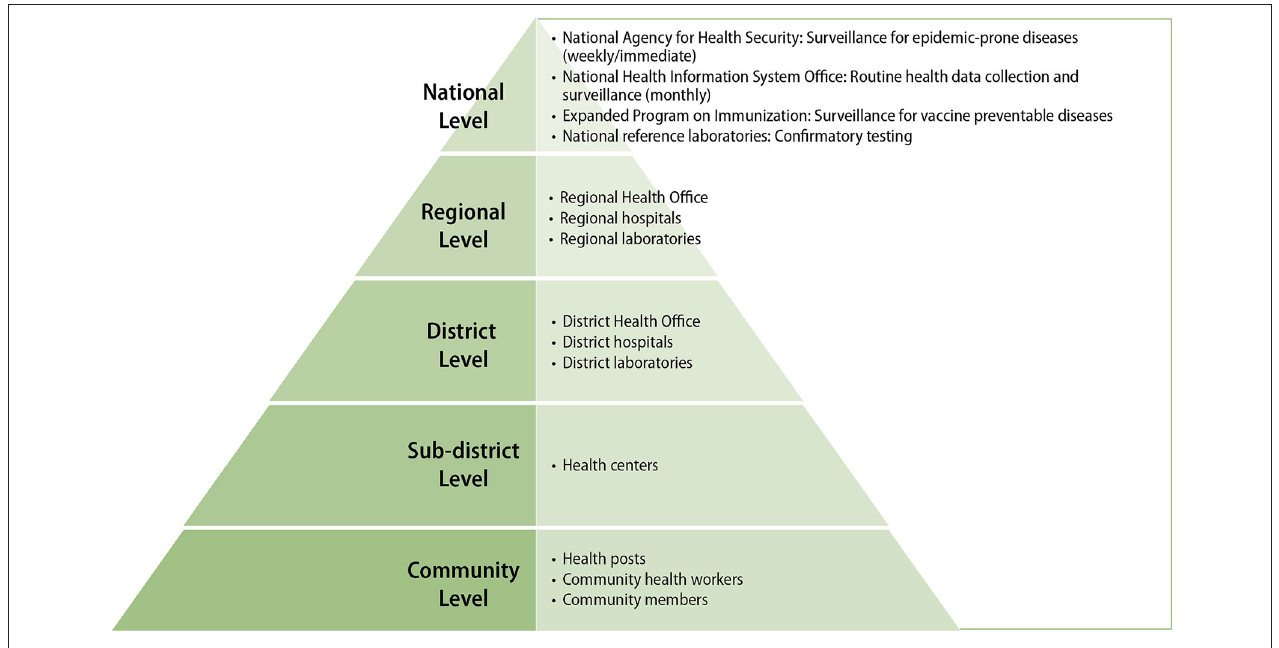
FIGURE 1 | Guinea’s health pyramid